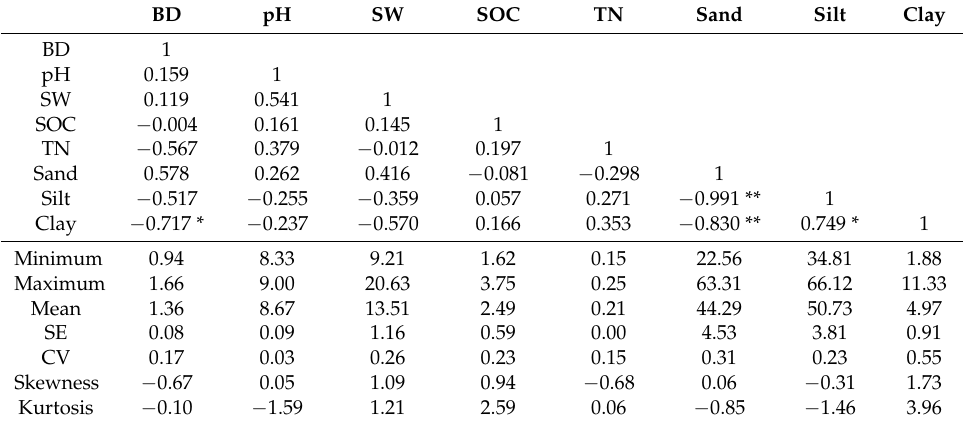
Table 1. Pearson correlation and classical statistics of soil properties of the samples ( n = 9) from the uncultivated coastal tidal flat. pH BD pH